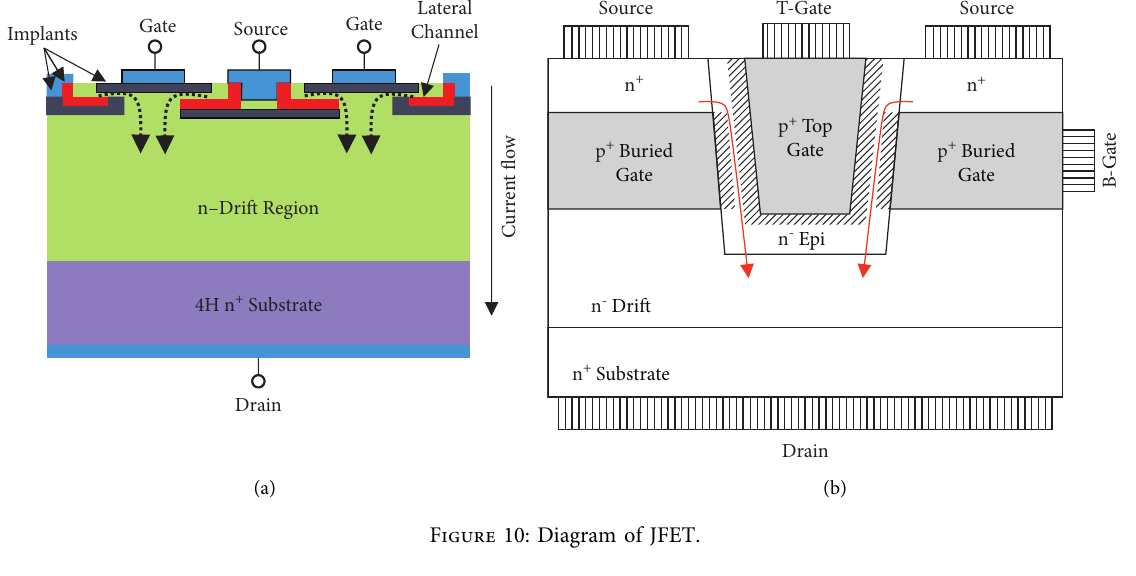
Figure 10: Diagram of